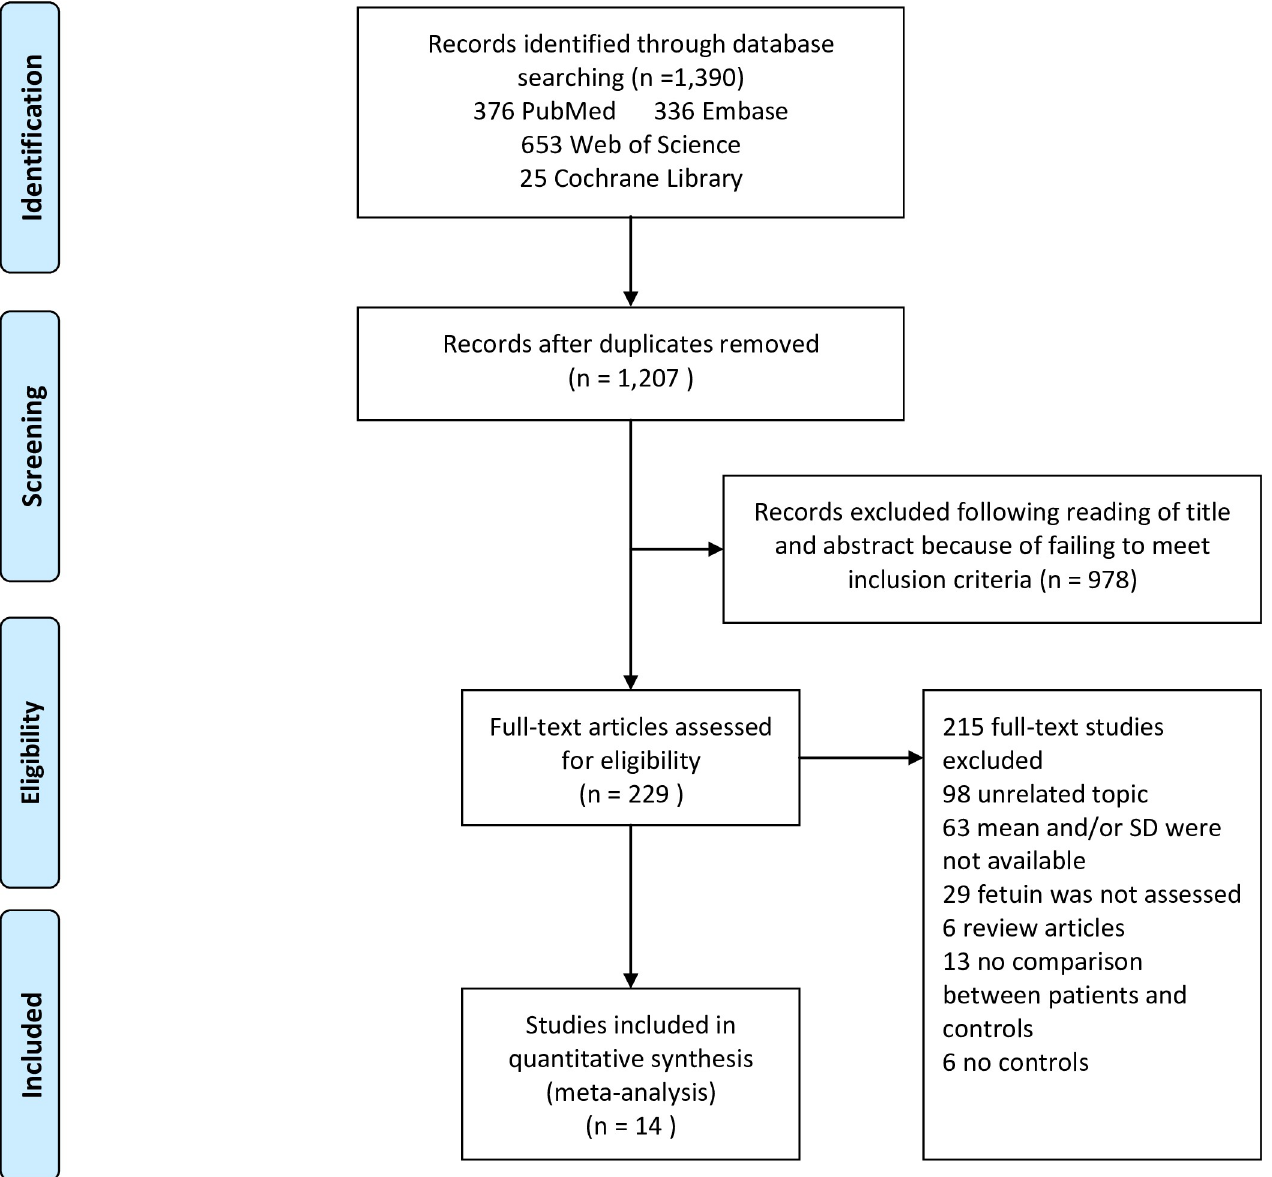
Fig 2. Flowchart of study selection. Showing the process by which relevant studies were retrieved from the databases, assessed, and selected, or excluded. Preferred reporting items for systematic reviews and meta-analyses (PRISMA) diagram for study search.